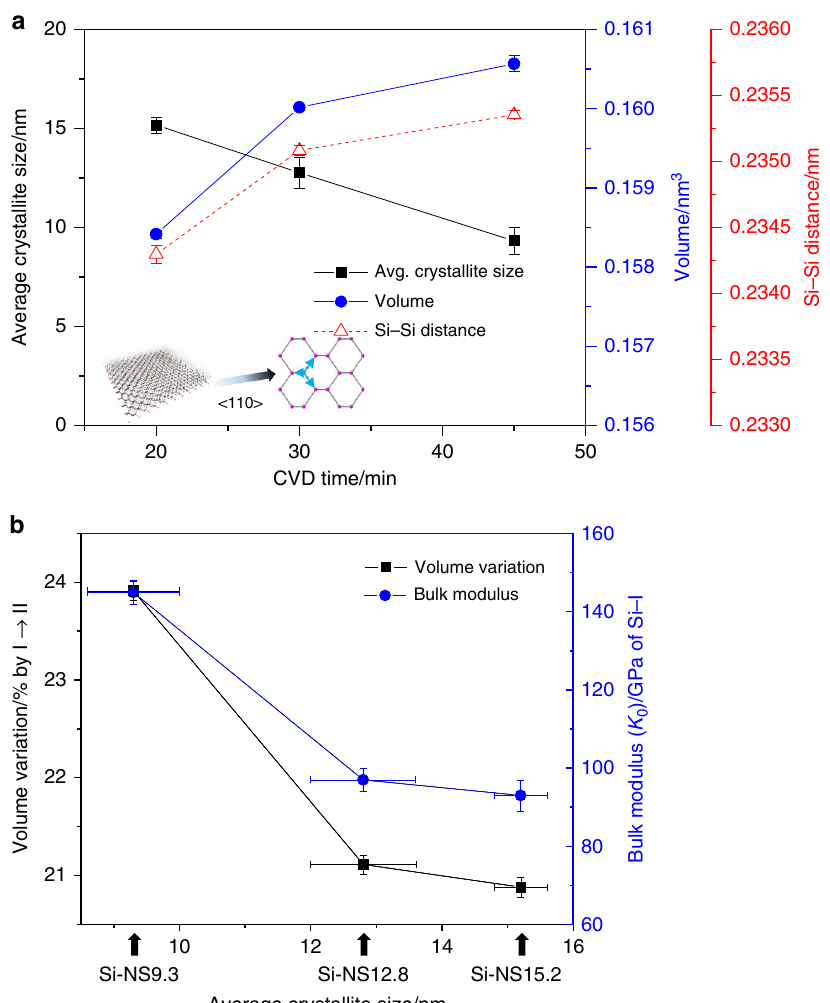
Fig. 2 Physical parameters and pressure response of Si-nanosheets. a Crystallite size and unit cell volume as a function of CVD reaction time. Using the peak width of the (111) re fl ection, crystallite sizes were derived using the Scherrer equation. b Bulk moduli of nanoscale Si-I phase and the degree of volume contraction upon Si-II transition as a function of crystallite size